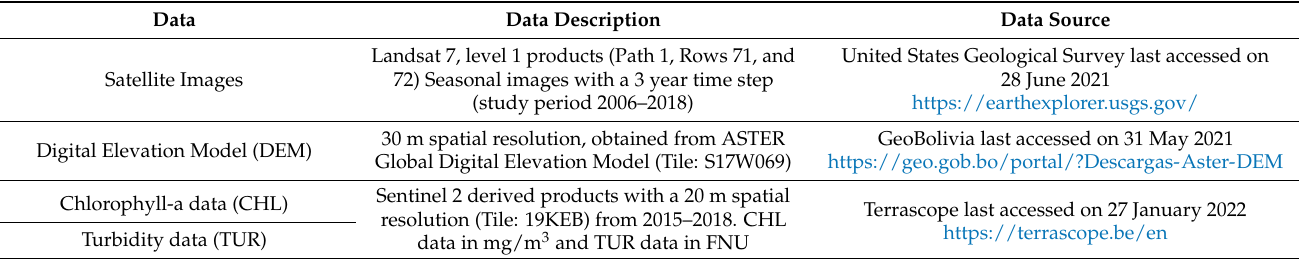
Table 1. Summary of data downloaded for this